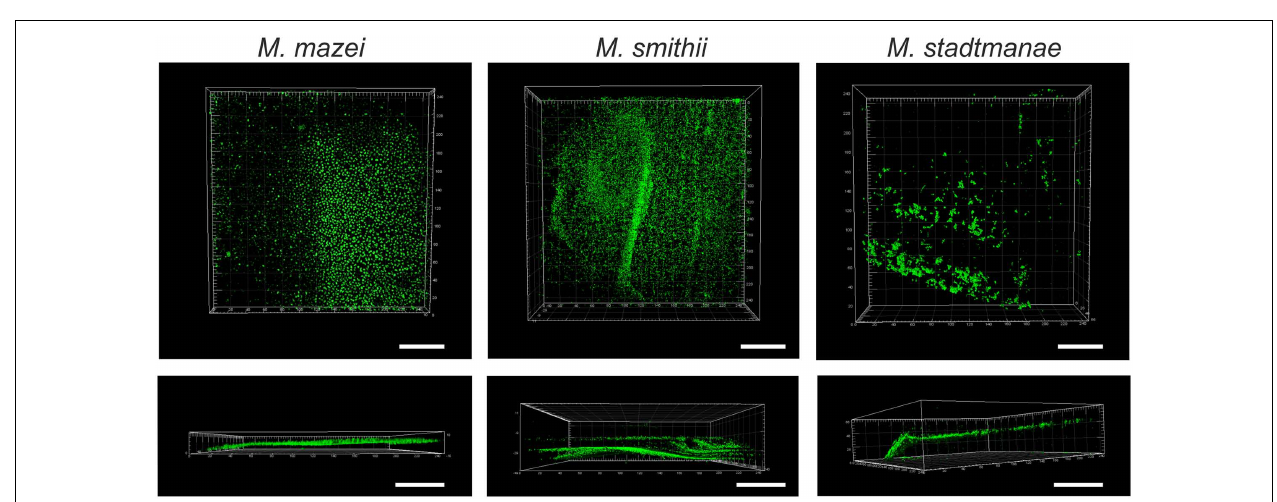
Methanobrevibacter smithii and Methanosphaera stadtmanae ; the cultures were supplemented with 1–2 pieces of mica. Growth on mica of all three strains was monitored by phase-contrast microscopy at defined time points of 48, 72, and 96 h.